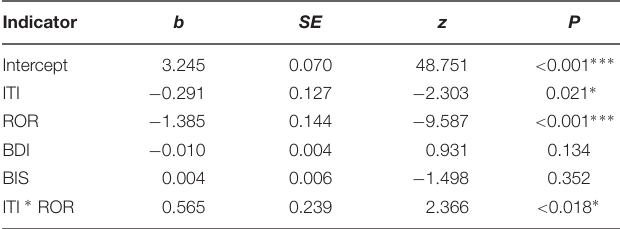
TABLE 2 | Restricted poisson regression model of extinction data with robust standard errors.